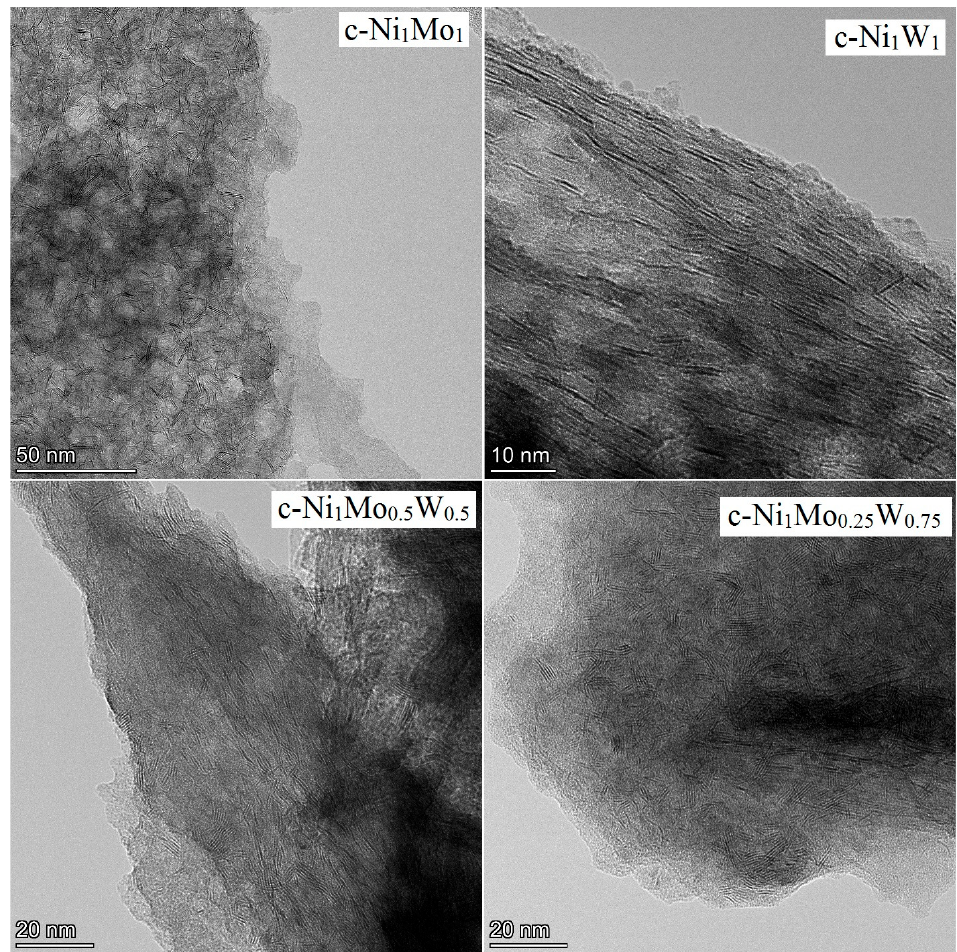
Figure 4. HRTEM images of the c—Ni 1 Mo 1 , c—Ni 1 W 1 , c—Ni 1 Mo 0.5 W 0.5 , and c—Ni 1 Mo 0.25 W 0.75 catalysts.